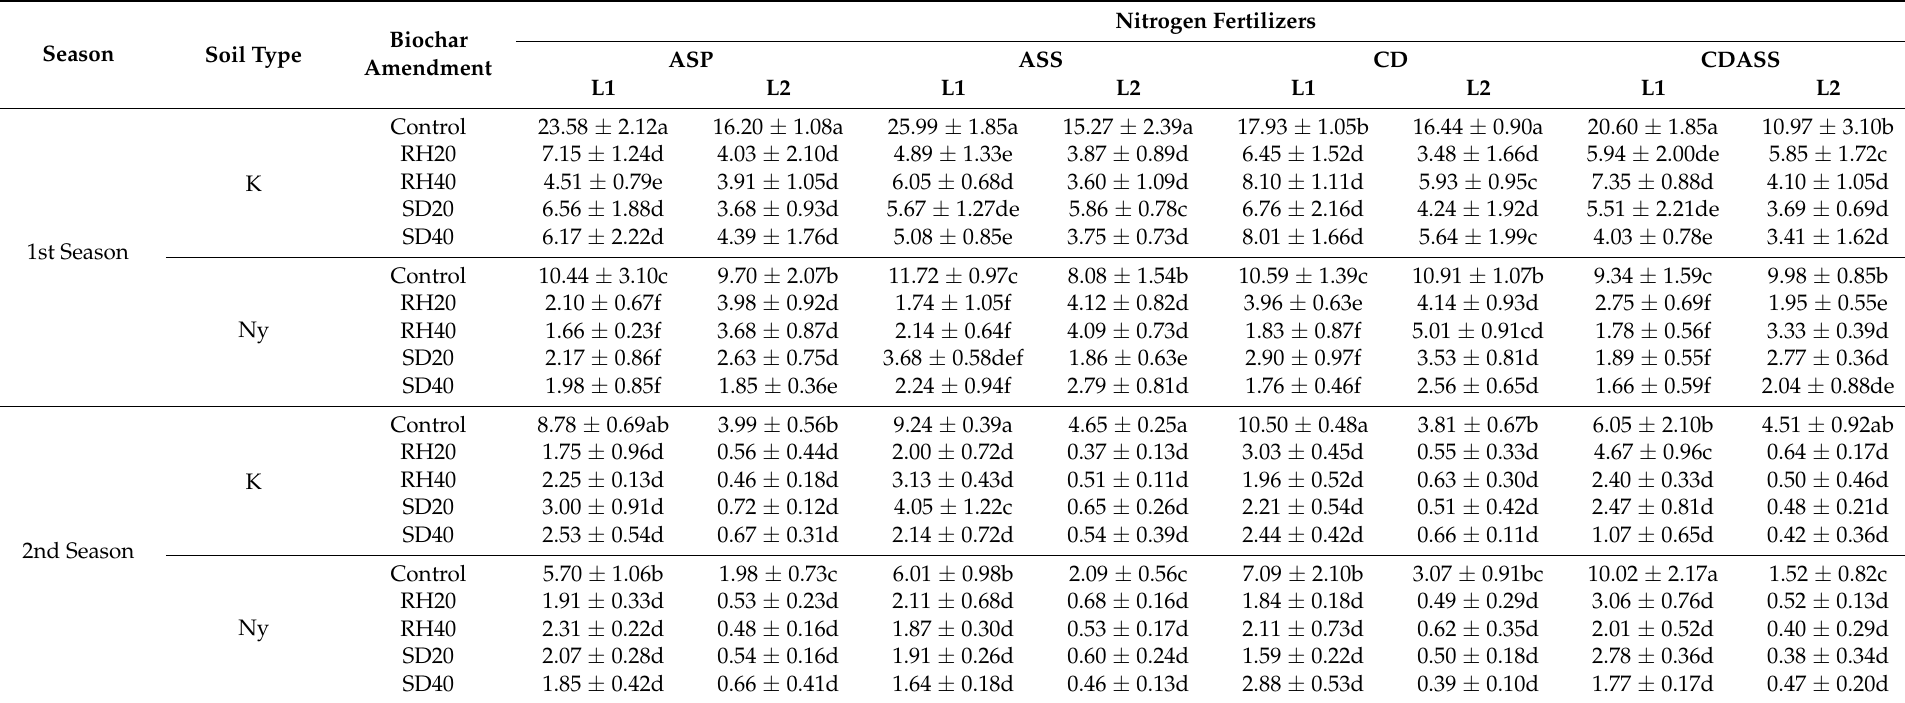
Table 2. Amount of NH 4+ -N leached from the